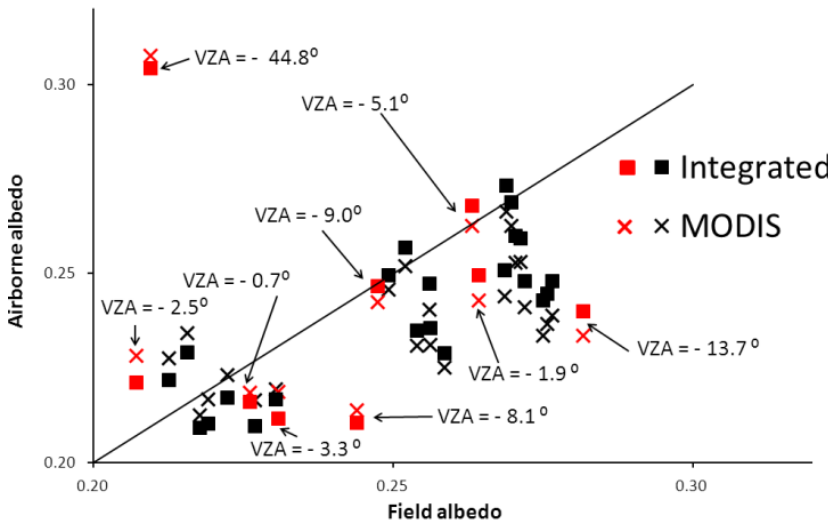
Figure 11. Field-measured albedos vs. airborne albedos for all the flights and all the sites. Marked in red are the sites viewed in the backscattering direction (negative View Zenith Angle, VZA) for flights perpendicular to the solar principal plane. The 1:1 line is plotted as a guide for the eye.